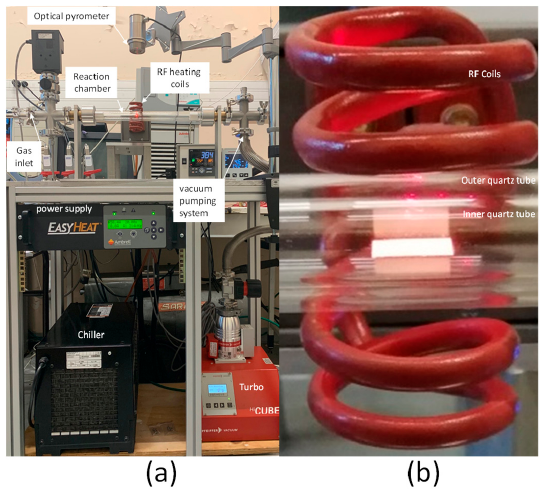
Figure 7. Induction reactor set-up: ( a ) Photograph of RF graphene growth set-up including a gas injection system, RF heating coils, power supply, chiller, reaction chamber, optical pyrometer, and a vacuum pumping system; ( b ) Photography of RF coils and a heated copper foil supported by the inner quartz tube. The gas flows in the inner and the outer quartz tubes.